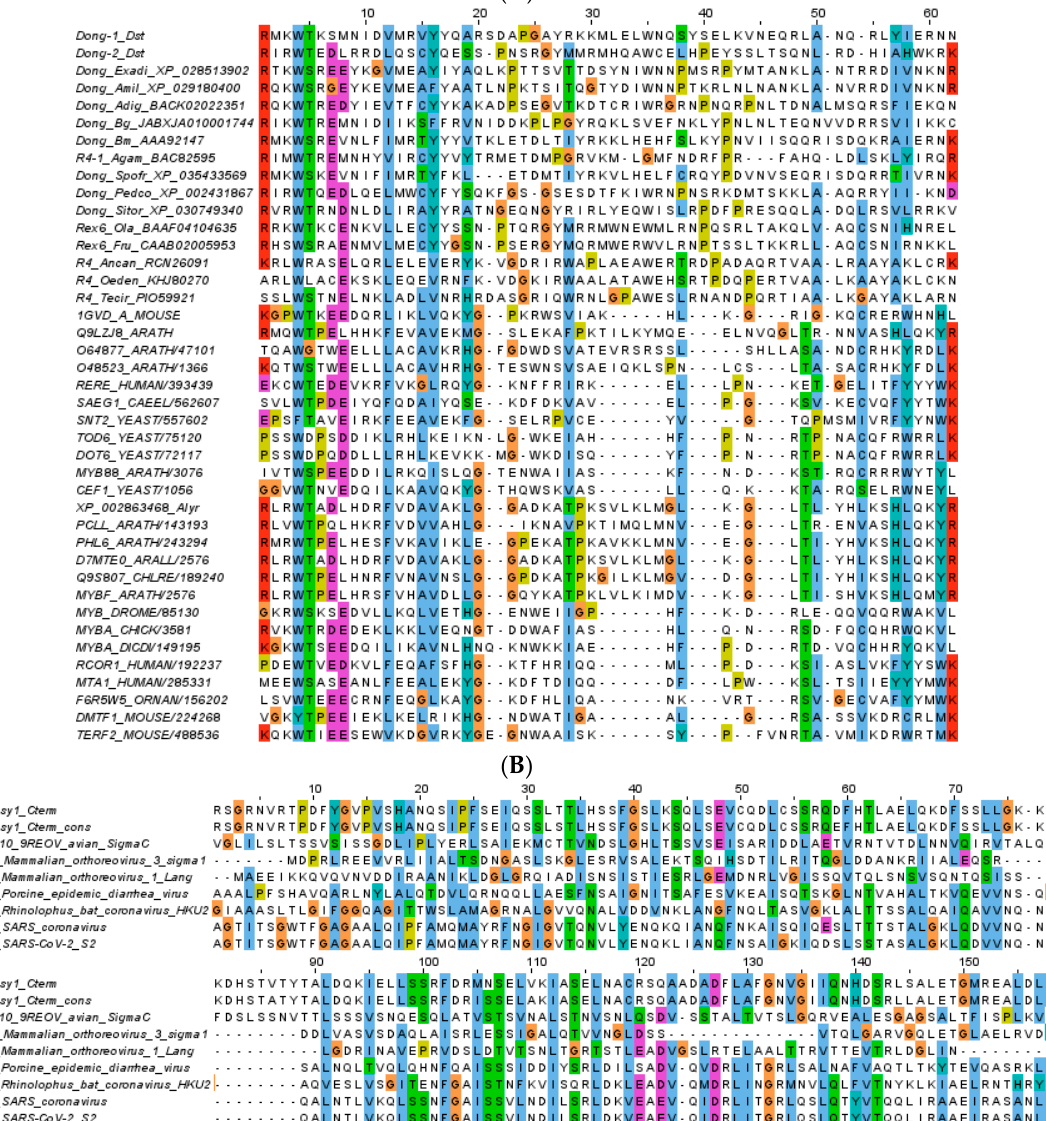
Figure 6. Regions of homology in R4/Dong ( A ) and Gypsy ( B ) retrotransposons of D. stevensoni . Multiple sequence alignments were visualized with Jalview [59]. (A) The alignment includes Dong1 and Dong2 ( D. stevensoni ) and related elements from cnidarians ( Exaiptasia diaphana, Acropora millepora, Acropora digitata ), mollusks ( Biomphalaria glabrata ), in- sects ( Bombyx mori, Anopheles gambiae, Spodoptera frugiperda, Pediculus humanus corporis, Sitophilus oryzae ), fish ( Oryzias latipes, Takifugu rubripes ) and nematodes ( Ancylostoma caninum, Oesophagostomum dentatum, Teladorsagia circumcincta ) with the corresponding accession numbers, followed by a representative selection of Myb-like domains from the PF00249 seed alignment (25 out of 147). (B) Structure-based alignment of D. stevensoni Gypsy1 C-terminus (amino acids 1322-1479 out of 1486) and the central helix domain of the spike (sigma) proteins from reoviruses and coronaviruses identified by HHpred, with the corresponding PDB accession numbers.